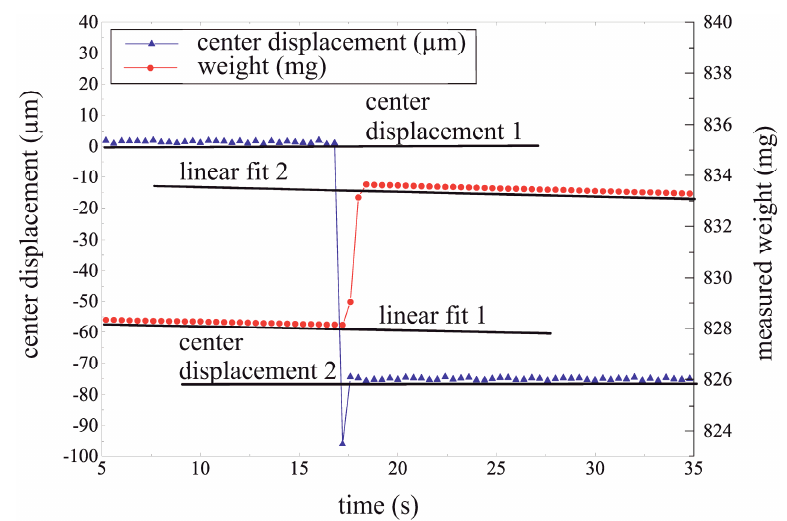
Figure 13. Measurement of the delivered volume and the center displacement at the same time. The center shows stable displacement result while the measured weight of the fluid changes with time. This is due to evaporation effects.